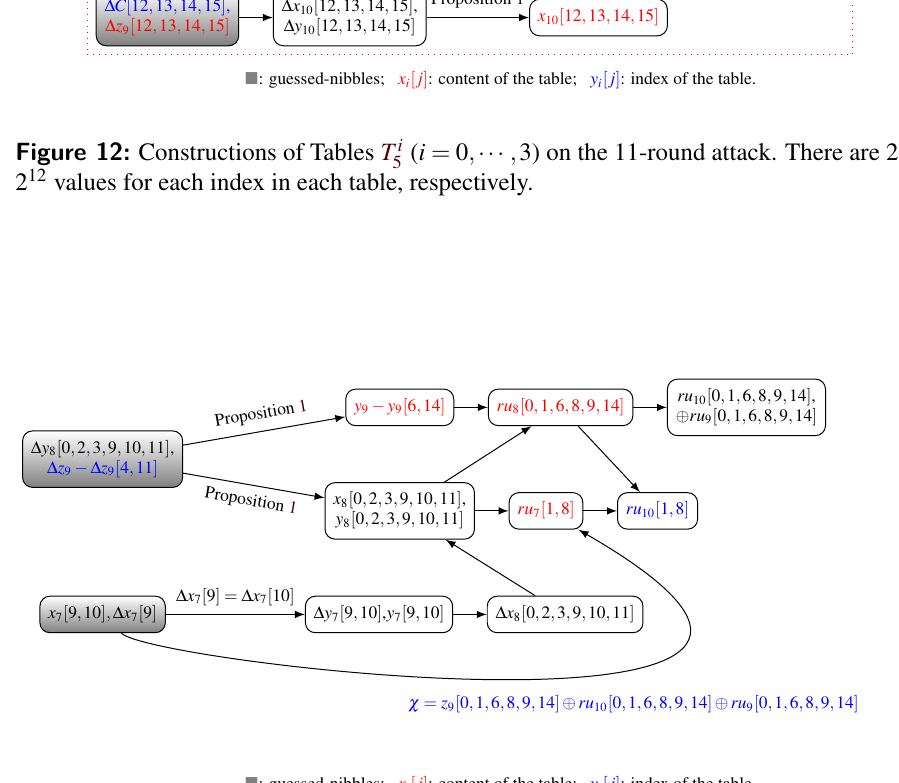
Figure 13: Construction of Table T 6 on the 11-round attack. There are 2 4 values for each index in